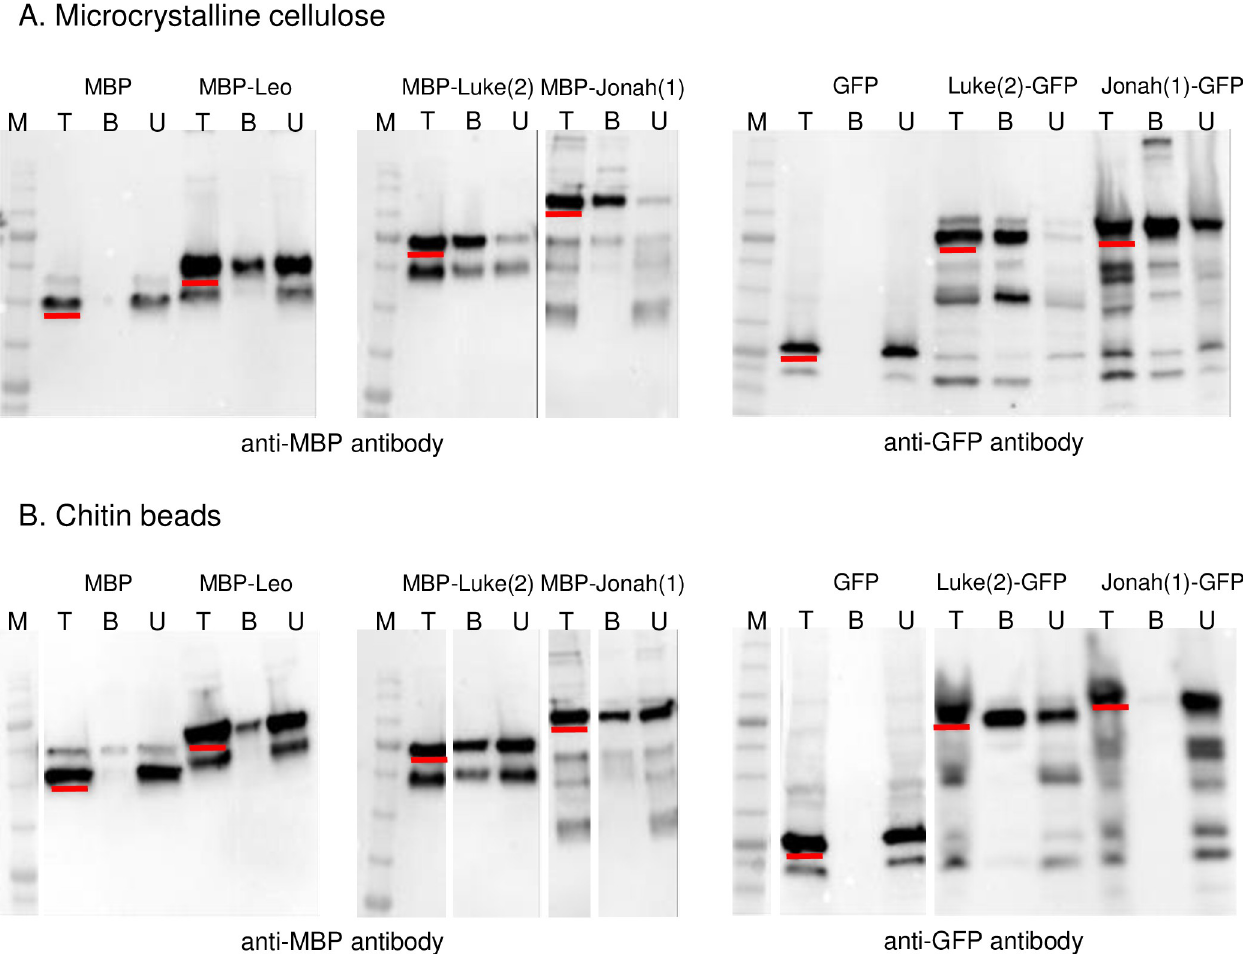
Fig 8. Western blots showed Luke(2), Leo, and Jonah(1) lectins fused to MBP or tagged with GFP bound well to microcrystalline cellulose, while binding to chitin beads was variable. MBP-lectin fusions and MBP alone, which were made as recombinant proteins in the periplasm of bacteria, were incubated with microcrystalline cellulose (A) or chitin beads (B). Total proteins (T), bound proteins (B), and unbound proteins (U), as well as molecular weight markers (M), were run on SDS-PAGE, transferred to PVDF membranes, and detected with an anti-MBP reagent. Full-length products in total fractions are underlined in red. MBP-Leo partially bound to microcrystalline cellulose and bound weakly, if at all to chitin. MBP-Luke(2) and MBP-Jonah(1) each bound more completely to cellulose than to chitin. MBP alone (negative control) did not bind to cellulose or chitin. Luke(2)-GFP, Jonah(1)-GFP, and GFP alone, each of which was expressed under the GAPDH promoter, were released from lysed trophozoites and incubated with microcrystalline cellulose or chitin beads. Luke(2)-GFP, which included some breakdown products, bound completely to cellulose and partially to chitin. Jonah(1)-GFP, which also included some breakdown products, bound partially to microcrystalline cellulose but not at all to chitin. GFP alone (negative control) did not bind to cellulose or chitin.